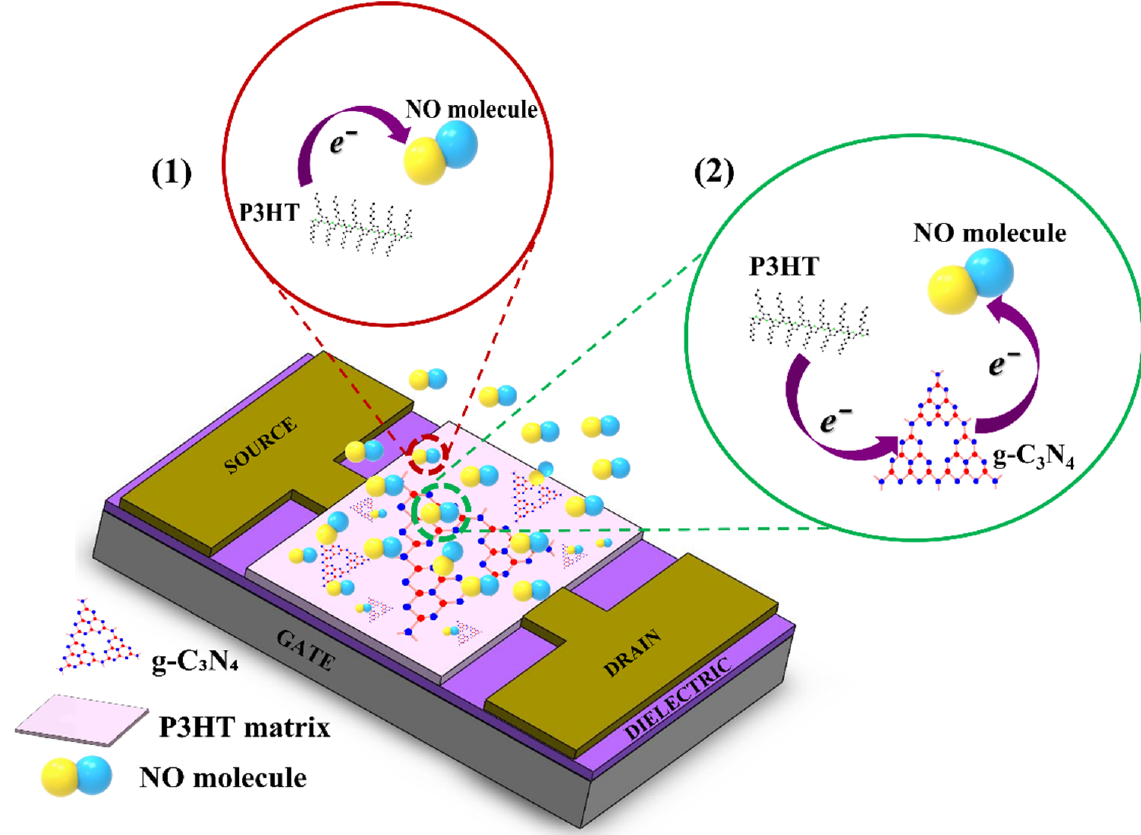
Figure 8. Schematic illustration of the gas sensing mechanism between (1) P3HT and NO molecules and (2) P3HT/g-C ₃ N ₄ and NO molecules.